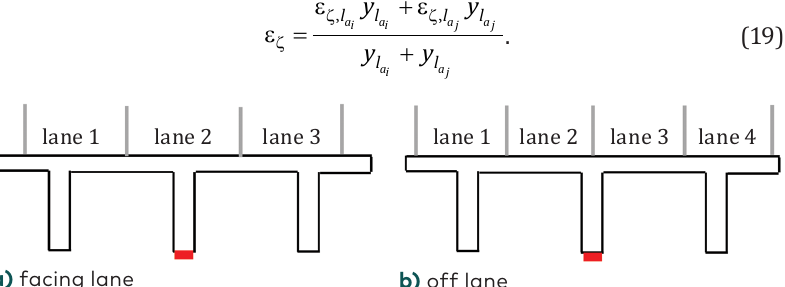
a) facing Figure 4. Monitoring unit with different lane distribution